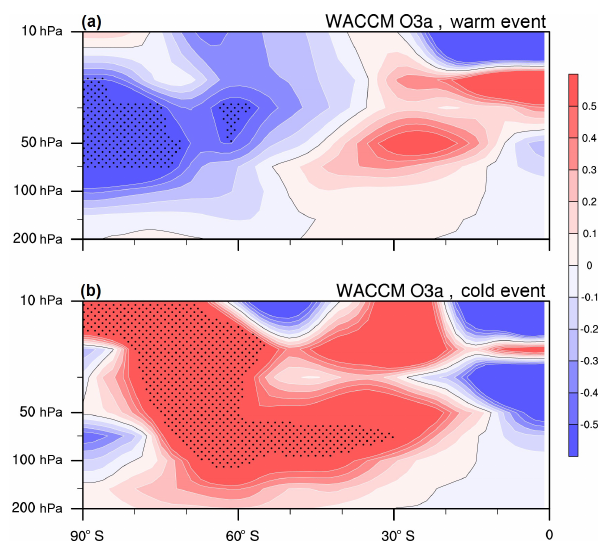
Figure 8. Zonal mean differences in ozone (ppmv) in austral spring between WACCM simulations (a) S2 and S1, and (b) S3 and S1. Statistical significance above the 95% confidence level is stippled. Statistical significance of the simulated anomalies is calculated us- ing the two-tailed Student’s t